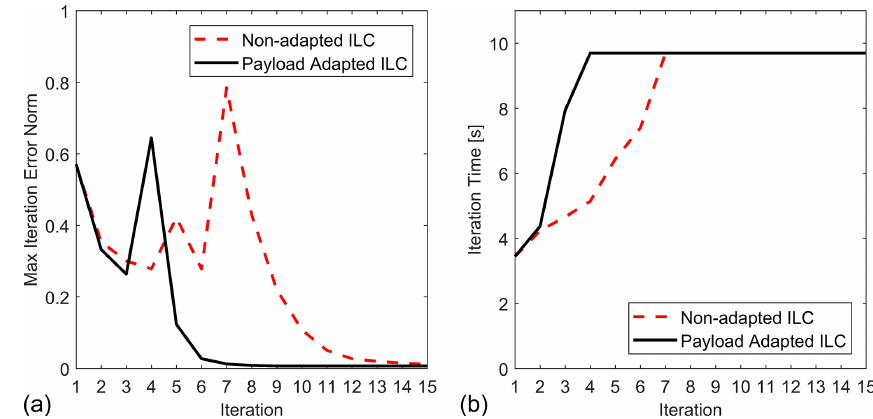
Figure 7. Convergence comparison of the ILC process for Trajectory E for non-adapted ILC and ILC adapted to the payload: (a) maximum tracking error and (b) iteration times.